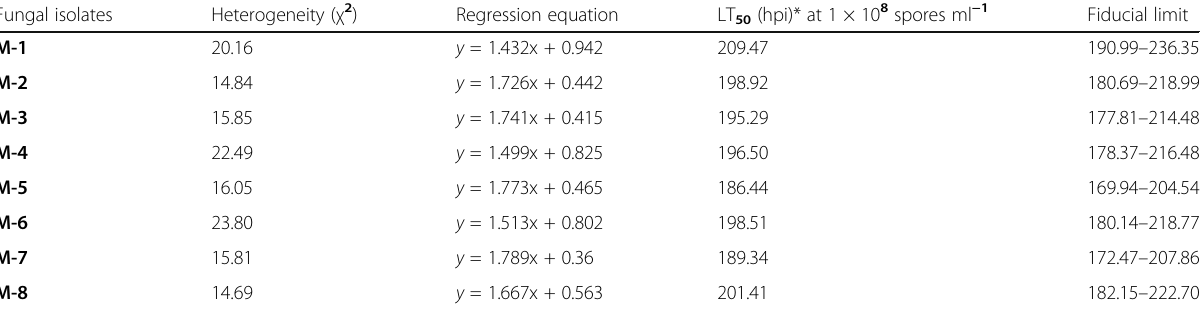
Table 3 Time mortality response of S. litura to different fungal isolates of M. anisopliae Fungal